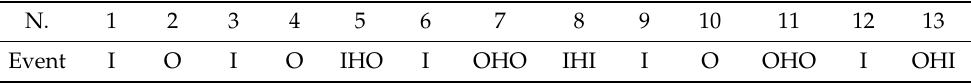
Table 5. The pattern of actions performed by the users. (For the acronyms of events, see Table 3). N.